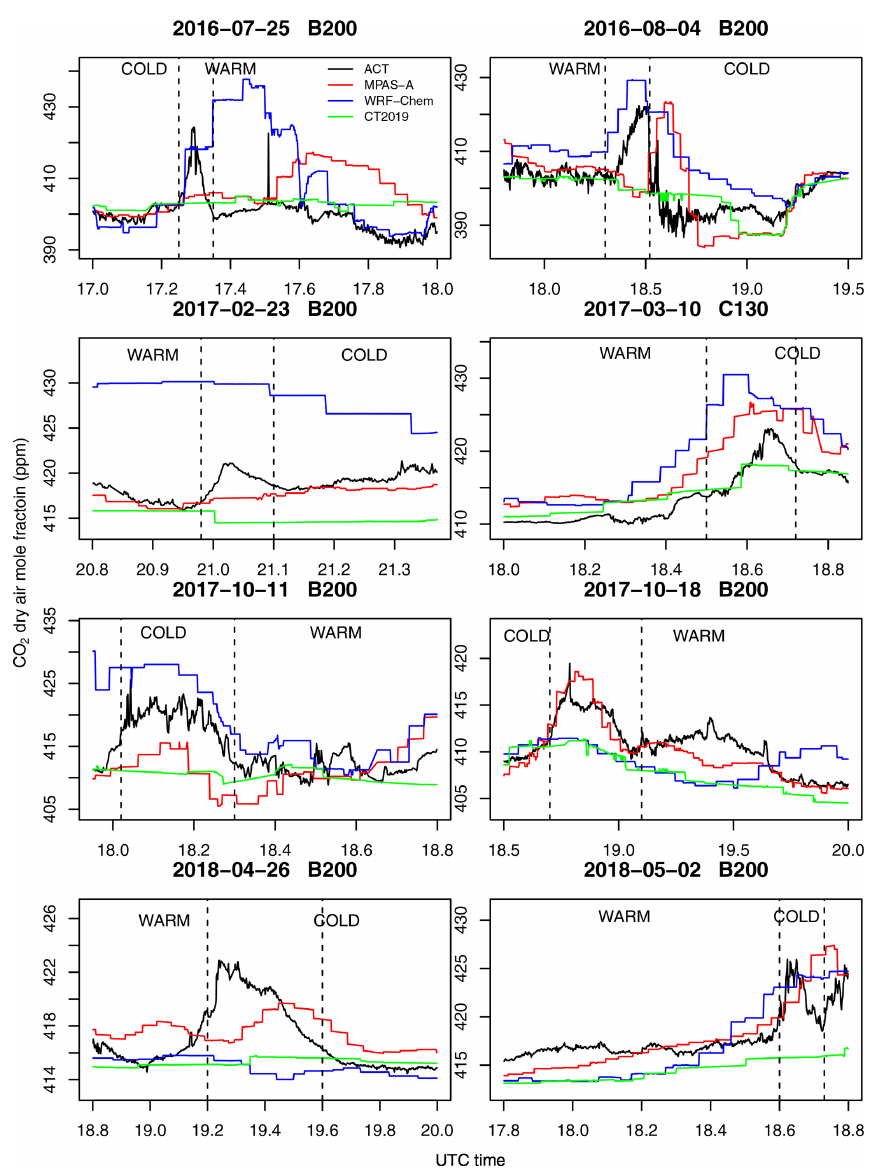
Figure 12. Comparison of CO 2 mole fraction in frontal-crossing constant altitude flight segments in BL between ACT aircraft measurements and model simulations. Flight date and aircraft type are labeled in title for each flight leg. The x axis indicates UTC time, and the y axis shows the CO 2 mole fraction (ppm). Aircraft measurements are in black, MPAS-A in red, WRF-Chem in blue, and CT2019 in green. In each figure, the pair of vertical dashed lines mark CO 2 enhancement observed by the aircraft along a frontal boundary, and the warm and cold sectors associated with the frontal boundary are labeled as warm and cold,